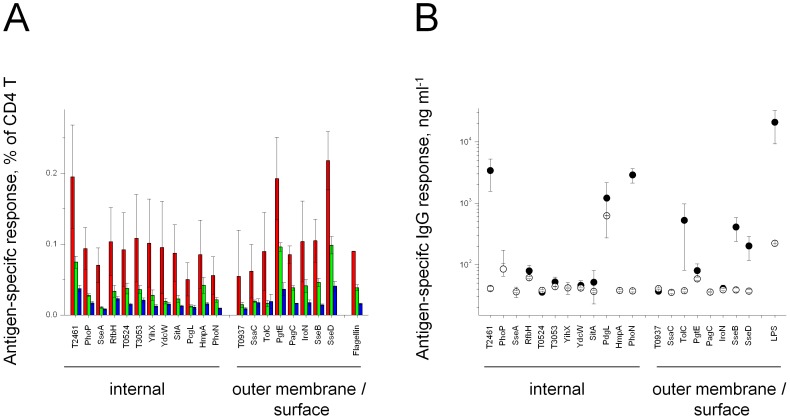
Cellular and humoral immune responses of convalescent Salmonella-infected mice to recombinant Salmonella antigens.
A) Antigen-specific CD4 T cell frequencies as detected by CD154 upregulation (red) and IFNγ (green) or IL-17 (blue) secretion. The data represent means ± SE of three mice. Responses to Salmonella antigens in non-infected control mice were subtracted (see also Fig. S1). B) Serum antibody responses to Salmonella antigens. The data represent means ± SE of 11 convalescent mice (filled circles) and means ± SE for ten non-infected control mice (open circles).